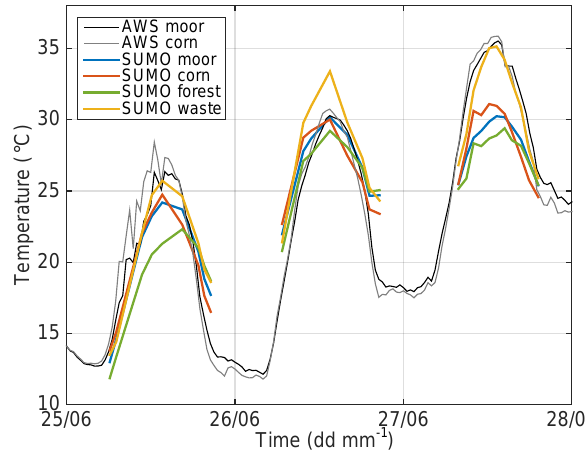
Figure 12. Time series of surface temperature from four differ- ent surface types at Site 2 measured using the downward-looking SUMO infrared sensor and two net